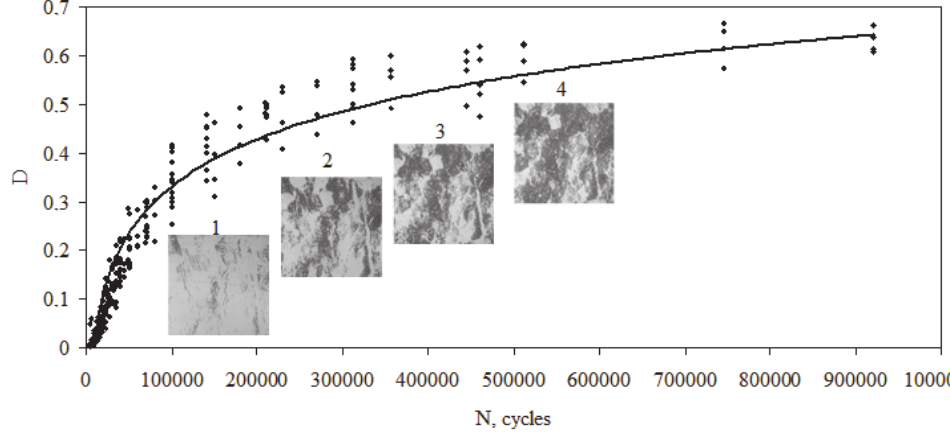
Figure 2: Evolution of the deformation relief under fatigue